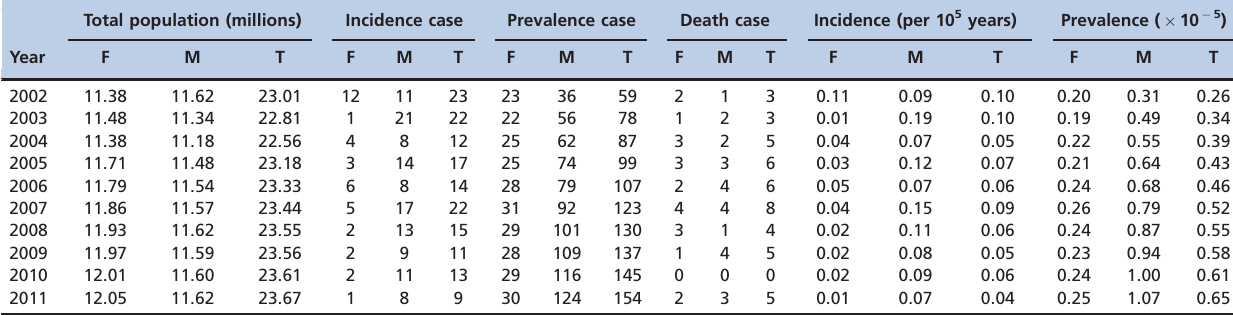
Table 2 - Incidence and prevalence of thromboangiitis obliterans in Taiwan from 2002 to 2011. Total population (millions) Incidence case Prevalence case Death case Incidence (per 10 5 years) Prevalence ( (cid:1) 10 (cid:3) 5